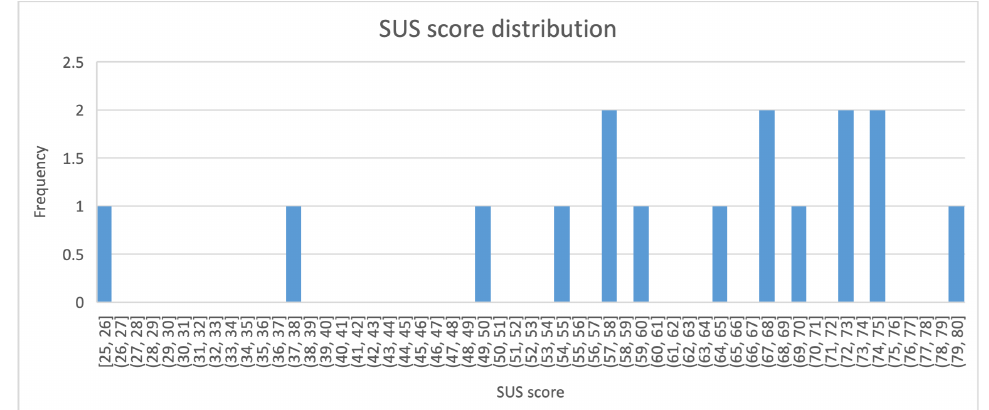
Figure 13. SUS scores of the interface developed for the correlation analysis of multivariate data use case. The X-axis indicates a certain range of the score. The Y-axis indicates the number of participants who gave the score within the